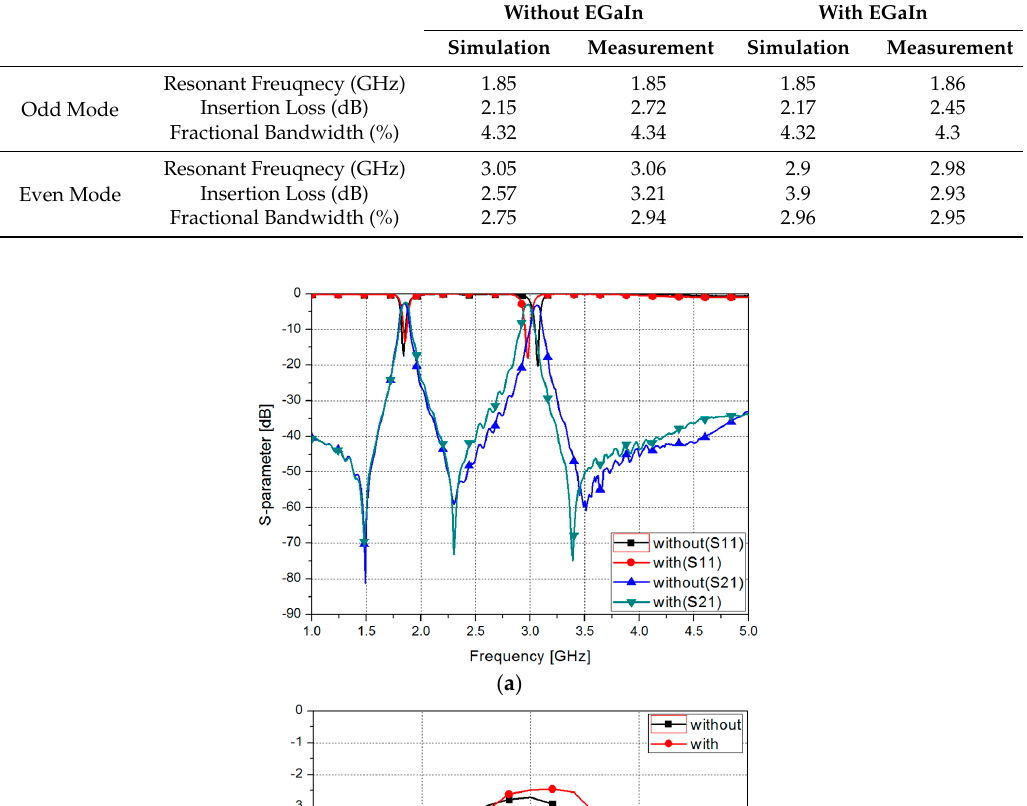
Table 1. Summary of simulated and measured results of the proposed filter.